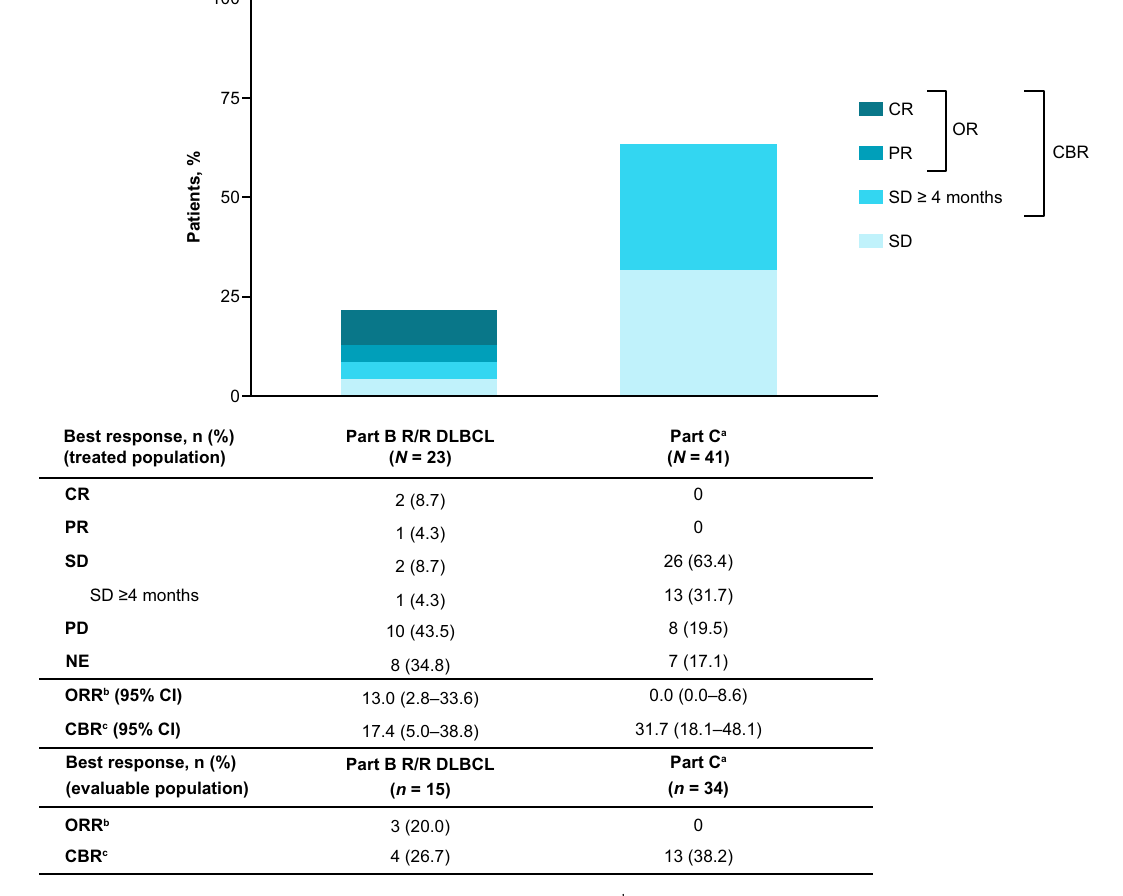
Fig. 3 | Summary of antitumoral activity. Source data are provided as a source data fi le. a Con fi rmedbestresponseispresentedforpartC,de fi nedasaconsecutive response of the same or better that is at least 4 weeks apart, regardless of